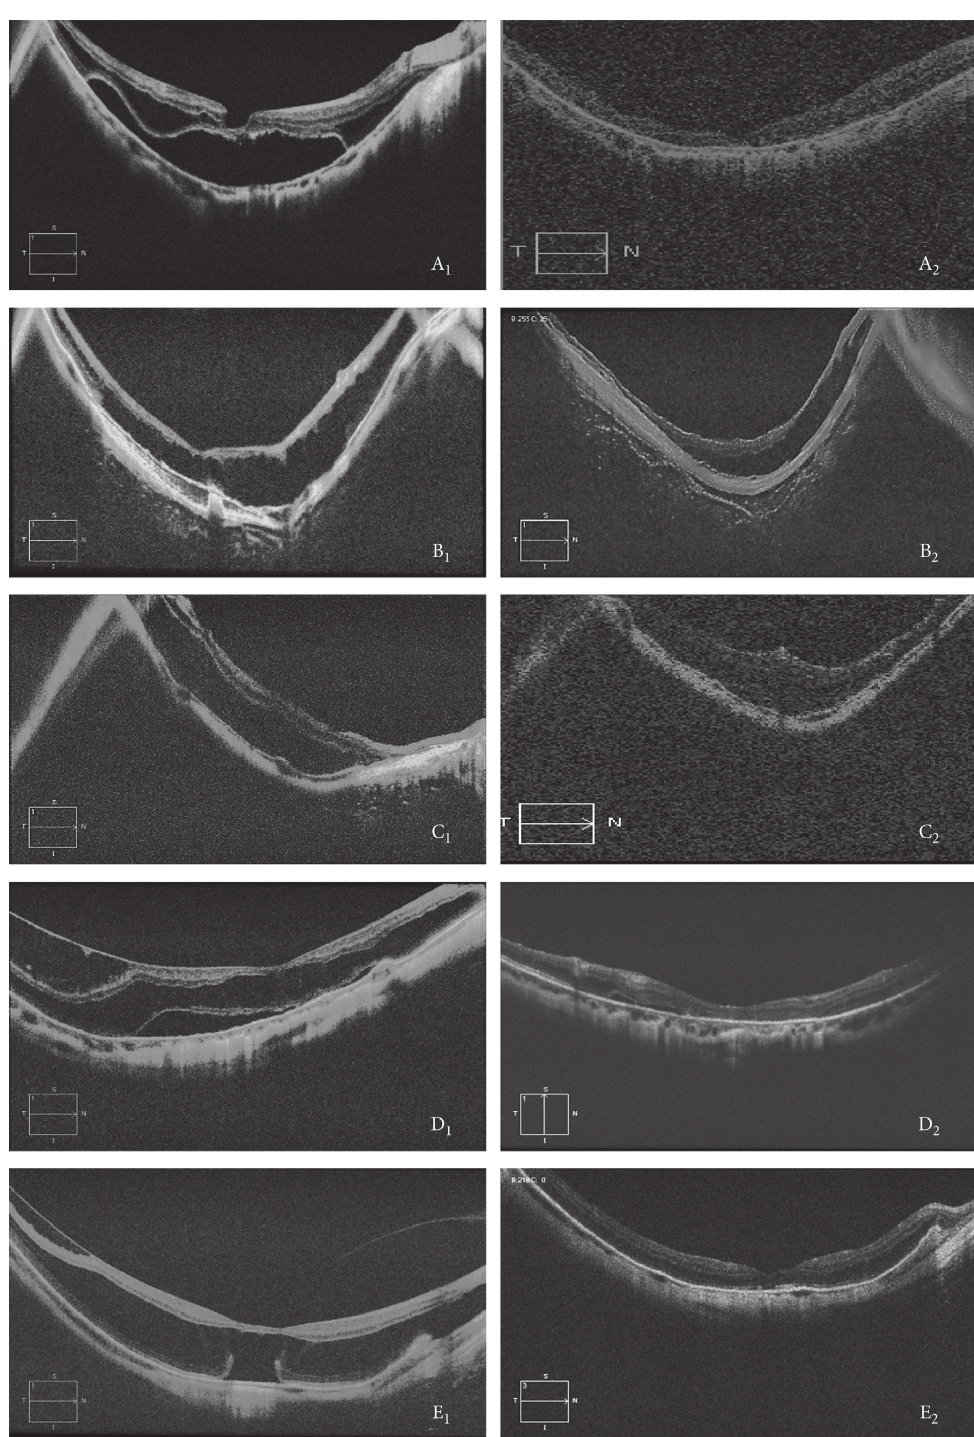
Figure 3: Raster lines comparison report of OCTimages (5 lines) before and after surgery. A 1 , the preoperative OCTimage of Case 1 showed high myopic foveoschisis and foveal detachment; A 2 , the postoperative OCT image of Case 1 showed that the foveoschisis disappeared and the foveal reattachment; B 1 , the preoperative OCT image of Case 2 showed serious high myopic foveoschisis in the outer layer; B 2 , the postoperative OCTimage of Case 2 showed foveoschisis obviously improved; C 1 , the preoperative OCTimage of Case 3 showed serious high myopic foveoschisis in the outer layer; C 2 , the postoperative OCTimage of Case 3 showed foveoschisis improved; D 1 , the preoperative OCT image of Case 4 showed serious high myopic foveoschisis both in the inner layer and in the outer layer, and detached foveola; D 2 , the postoperative OCT image of Case 4 showed that the foveoschisis disappeared and the foveola reattached nearly; E 1 , the preoperative OCT image of Case 5 showed myopic foveoschisis both in the inner layer and in the outer layer, and detached local foveola; E 2 , the postoperative OCT image of Case 5 showed that the foveoschisis disappeared and the foveola reattached